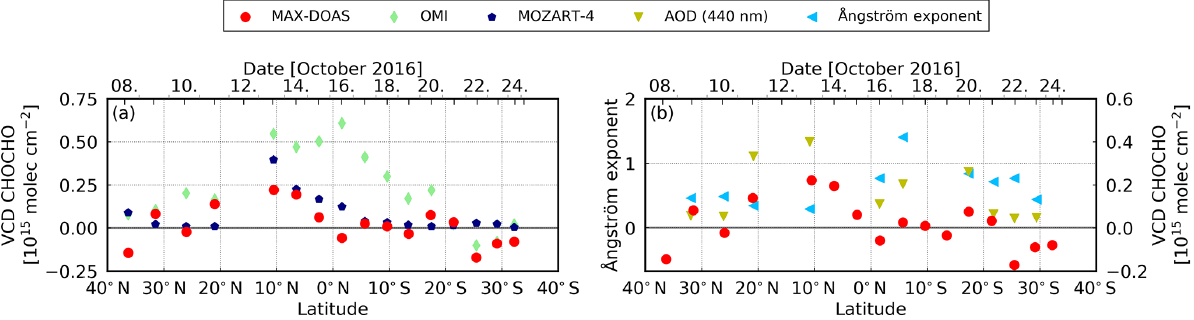
Figure 12. The latitudinal dependency (from north to south) of daily mean CHOCHO VCDs over the Atlantic Ocean. (a) Enhanced CHOCHO values can be observed in the area of expected outflow. As for HCHO, satellite observations and model values are enhanced in this area. (b) AOD from AERONET dataset is enhanced in this area. For this plot, a similar axis as for Fig. 10 is used.